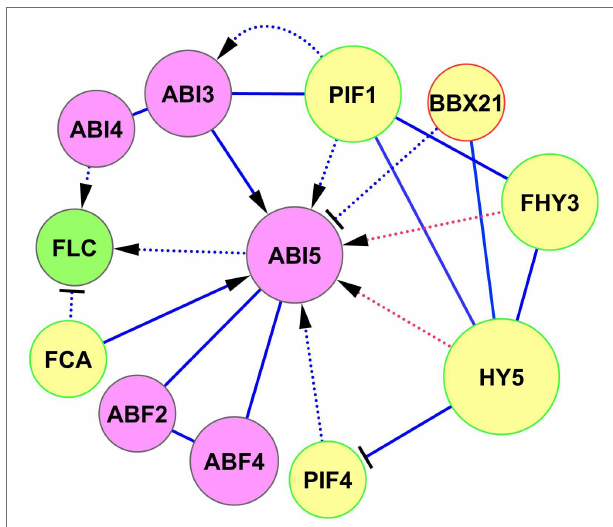
FIGURE 3 | Crosslinking of ABA and light signaling on ABI5. Solid lines represent protein–protein interactions presented in PAIR, BioGRID, and IntAct, and dotted lines represent transcriptional regulation. ABA-responsive element binding factors of the ABA signaling network, such as ABF2, ABF4, and ABI3 (involved in abiotic stress defense and stress memory) cooperate with ABI5 to jointly regulate its function. Light signaling proteins PIF1, PIF4, FHY3/FAR1, and HY5 activate the expression of ABI5 , whereas BBX21 inhibits its expression. FCA activates ABI5 by protein–protein interaction and jointly with ABI5 regulates expression of FLC . FLC and FCA are proteins that substantially reduce plant water use and are important for heat and cold adaptation. Red activator lines from FHY3/FAR1 and HY5 indicate cooperative effects HY5, DET1, and FHY3 signaling on ABI5 function (see also details in Figure 4 ). Abbreviations: ABI3,4,5, ABA insensitive 3,4,5; ABFs, abscisic acid responsive elements-binding factors; PIFs, phytochrome-interacting transcription factors; HY5, transcription factor HY5 (protein long hypocotyls 5); BBX21, B-box zinc finger transcription factor BBX21; FHY3/FAR1, far-red elongated hypocotyls 3/protein far-red impaired response 1; FCA, flowering time control protein; FLC, MADS-box protein flowering locus